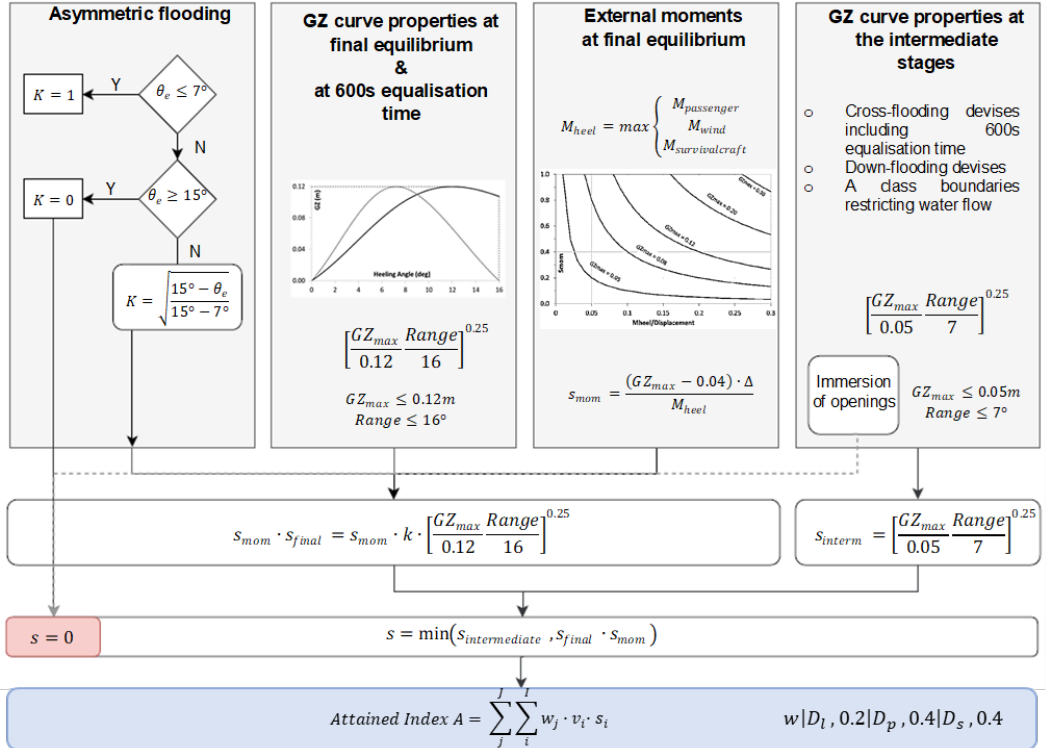
Figure 5. Calculation process of s-factor as per SOLAS 2009 accounting for external moments ( M ) at final and intermediate stages of flooding ( θ e —equilibrium heel angle; GZ max —maximum positive righting lever; Range —range of positive righting lever; M heel —heeling moment; M wind —wind moment; M passenger —heeling moment due to the movement of passengers; M survivalcraft —heeling moment due to the launching of all fully loaded davit-launched survival craft on one side of the ship; s int ermediate —probability to survive all intermediate flooding stages until the final equilibrium stage; s final —probability to survive in the final equilibrium stage of flooding; s mom —probability to survive heeling moments; D l , D p , D s represents deepest subdivision draught, light service draught and partial subdivision draught, respectively).